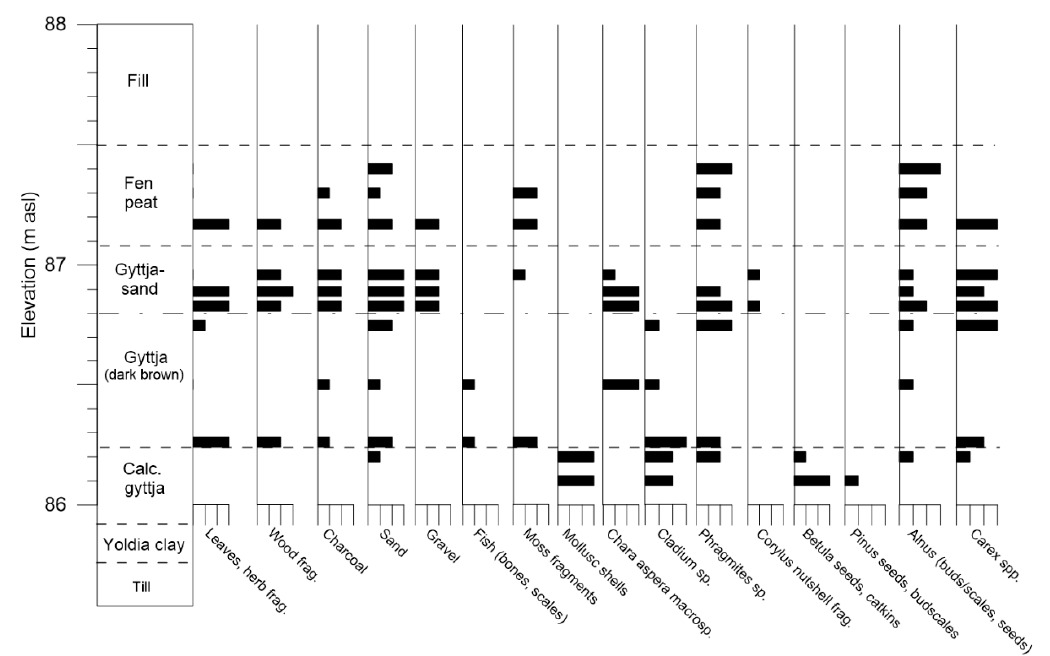
Figure 5. Macrofossil remains from section C 13059 at Strandvägen. Mainly terrestrial and telematic / submerged organic plant material is presented, but lithic, faunal and archaeological macroscopic remains, relevant for water depth reconstruction and changes in the sedimentary environment, are also included. The material is quantified according to a three graded scale (1–3). For fragmented material, 1 represents single occurrences in the whole sample, 3 represents material dominating the sample, and 2 is the intermediate grade used when a type of macrofossil could be described as “common” within the sample. Seeds / fruits of Cladium , Carex , and all tree taxa are presented as amalgamated with tissue fragments, catkin scales, budscales and macrospores. The scale is relative to the taxa in all samples; generally, 1 represents 1–9 diaspores, and 3 represents > 50 diaspores.